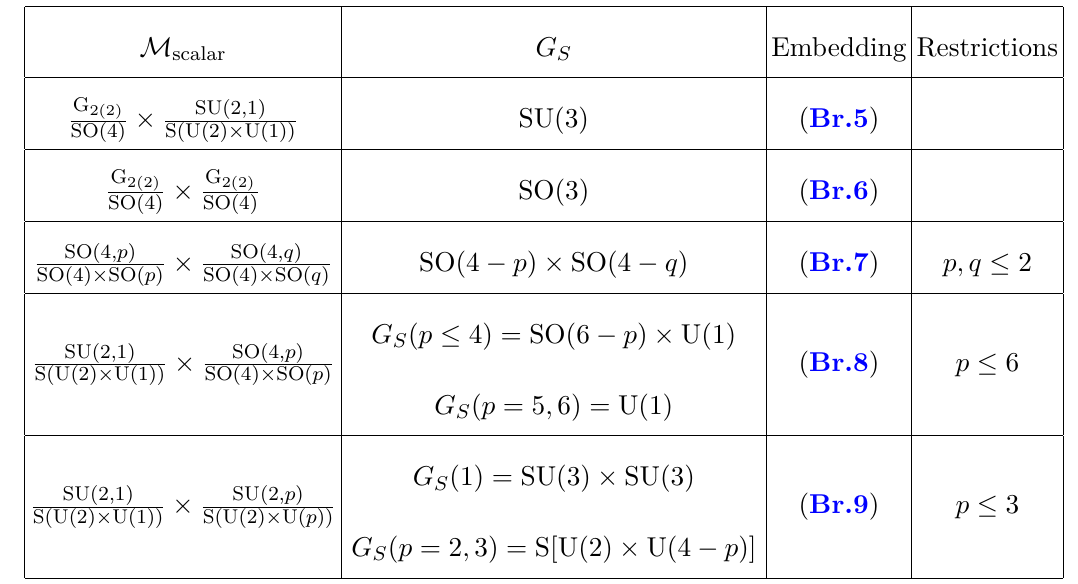
Table 3 . Summary of a subset of possible truncations to N = 4 gauged supergravities, leading to a product of quaternionic-Kähler manifold. G S denotes the structure group, with the notation G S ( p ) where there is a family of scalar manifolds, labelled by p and M scalar is the scalar manifold. We also list the embedding of G S in SO(12) and the restrictions on the matter that can be kept in a truncation, where